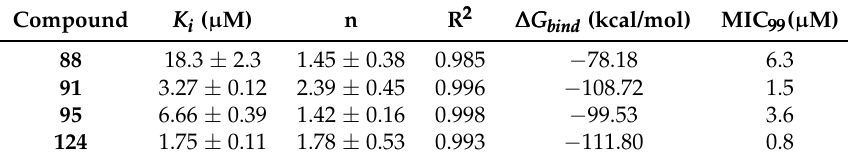
Table 2. Inhibition kinetics parameters, estimated binding free energies ( ∆ G bind ) and cellular activities of SerB2 inhibitors 88 , 91 , 95 and 124 . Inhibition constants ( K i ) and Hill coefficient (n) values are reported with 95% confidence intervals. Goodness of fit of the Hill-type model used (Equation (3)) are reported as R 2 values in the fourth column. ∆ G bind were calculated following induced fit docking experiments by the MM/GBSA method. Minimum inhibitory concentrations (MIC 99 ) were determined against M. tuberculosis strain H37Rv in